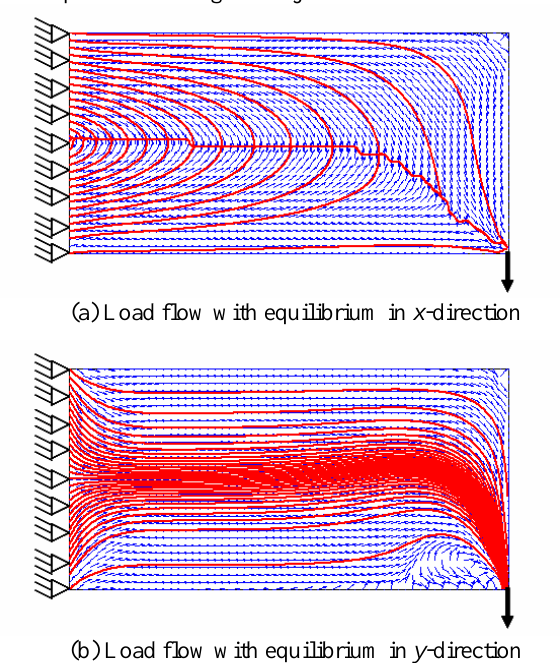
Fig. 14. Orientation of load flow with left side of the structure fully